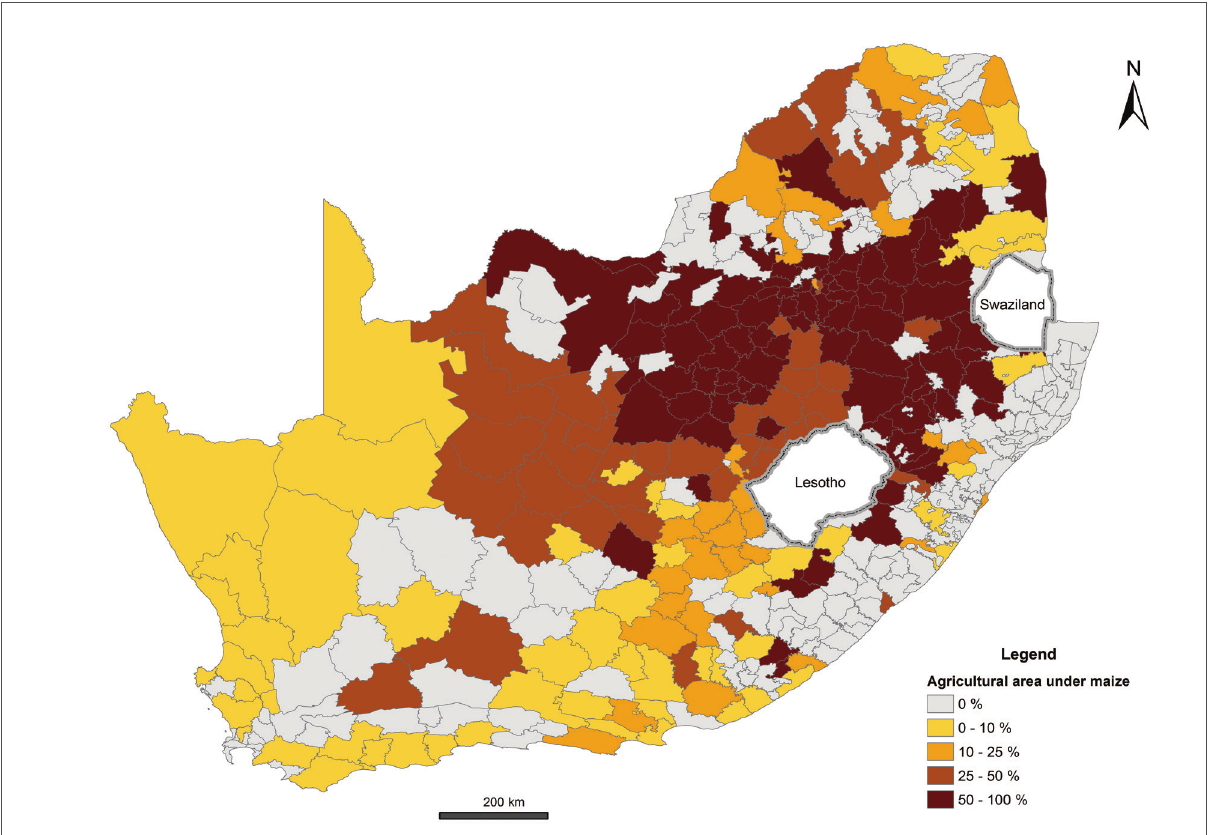
Figure 1: Proportion of national agricultural area under maize per magisterial district in South